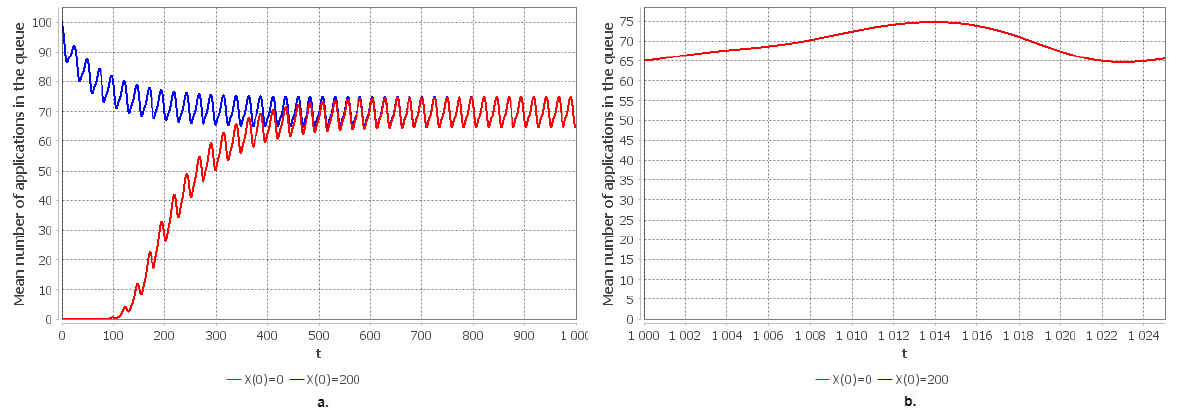
Figure 6. ( a ) The mean of applications in the queue Q ( t ) for t ∈ [ 0,1304 ] . ( b ) Approximation of the limiting mean of applications in the queue Q ( t ) for t ∈ [ 1304,1329 ]